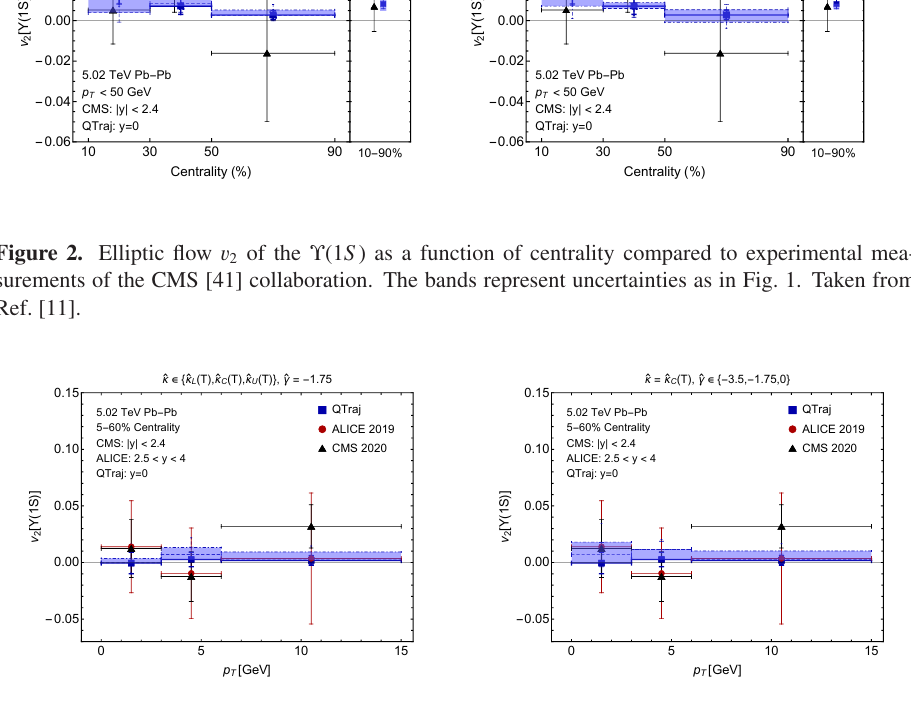
Figure 3. Elliptic flow v 2 of the ⌥ (1 S ) as a function of p T compared to experimental measurements of the ALICE [40] and CMS [41] collaborations. The bands represent uncertainties as in Fig. 1. Taken from Ref. Figure 1. Nuclear modification factor R AA of the ⌥ (1 S ), ⌥ (2 S ), and ⌥ (3 S ) as a function of p T compared to experimental measurements. The experimental data are taken from the ALICE [38], ATLAS [39], and CMS [36] collaborations. The bands in the theoretical curves indicate variation with respect to ˆ  ( T ) (left) and ˆ γ (right). The central curves represent the central values of ˆ  ( T ) and ˆ γ , and the dashed and dot-dashed lines represent the lower and upper values, respectively, of ˆ  ( T ) and ˆ γ . Taken from Ref. [11].